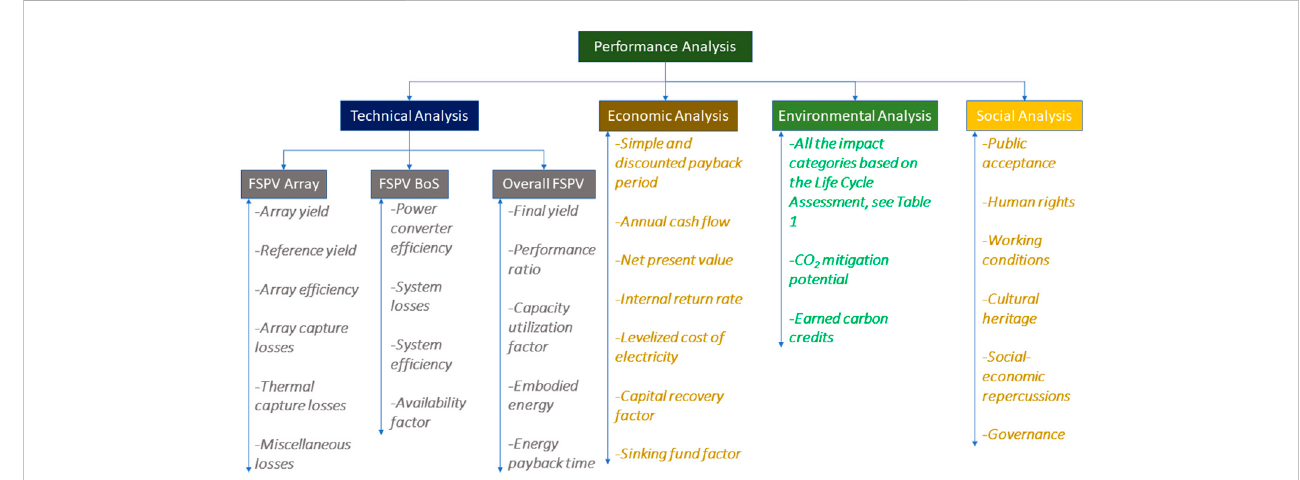
FIGURE 2 Categorization of system parameters of an on-grid PV system for performance